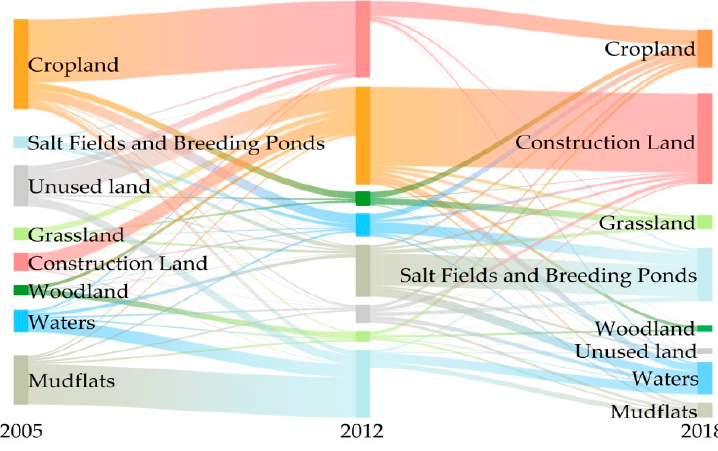
Figure 4. Separate mulberry map of the landscape type transfer matrix.